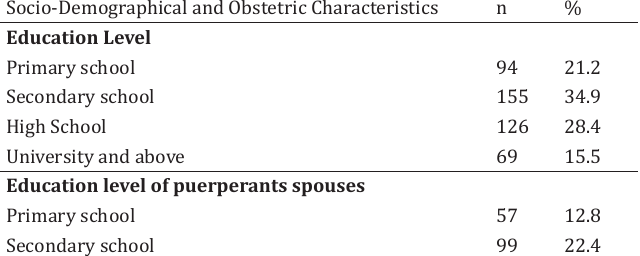
Socio-Demographical and Obstetric Characteristics